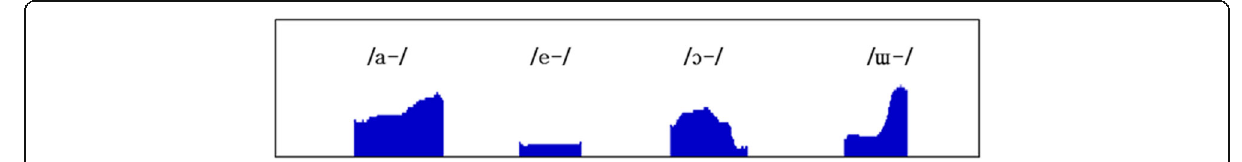
Fig. 2 Nasogram slope types of Vietnamese cleft palate children